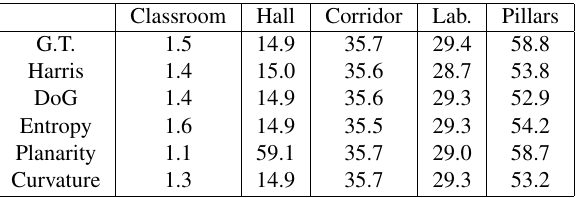
the ground truth. This does not mean that the coarse registration, or the keypoints obtained are not suitable, but it does mean that the automatic registration in these cases requires further work.